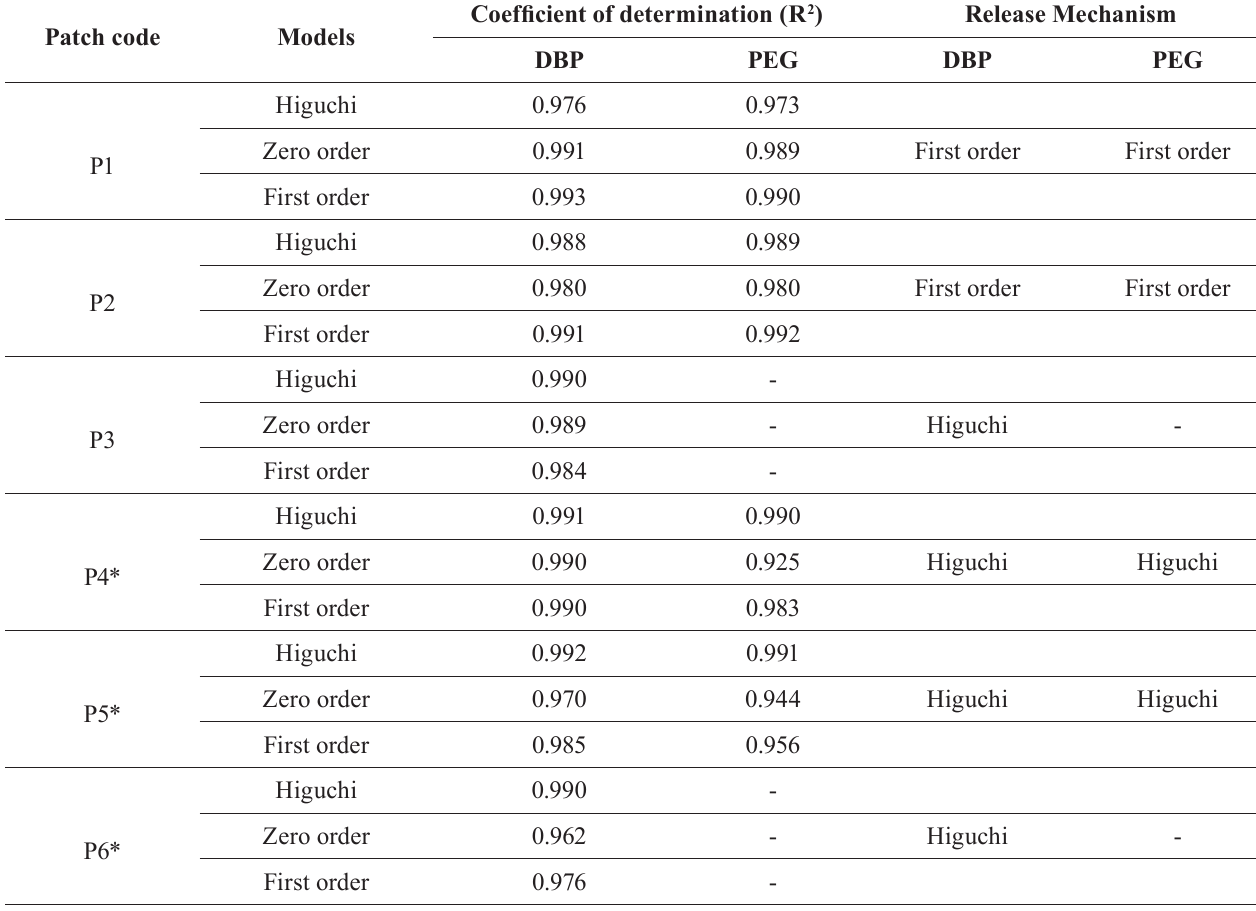
TABLE IX - Kinetic study of pure OND and SD loaded patches